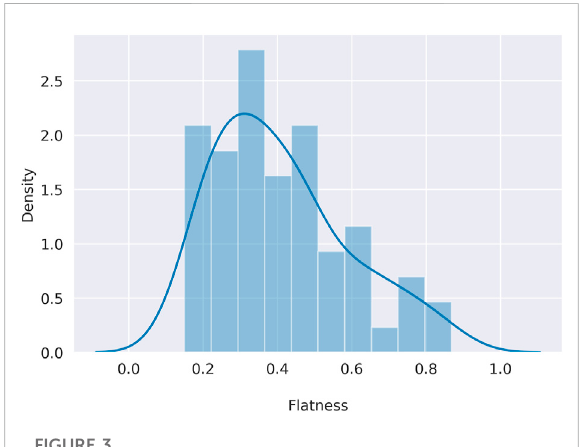
FIGURE 3 Distribution oftheCOSMIC fl atness.Onthe x axisthe fl atness de fi ned in Eq. 2, on the y axis the density for each fl atness